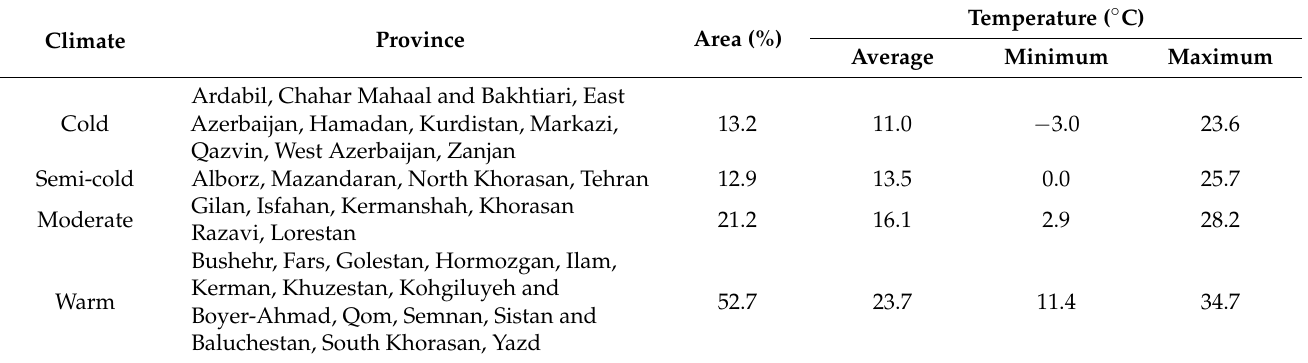
Table 1. Classification of provinces based on climatic conditions as the definition of